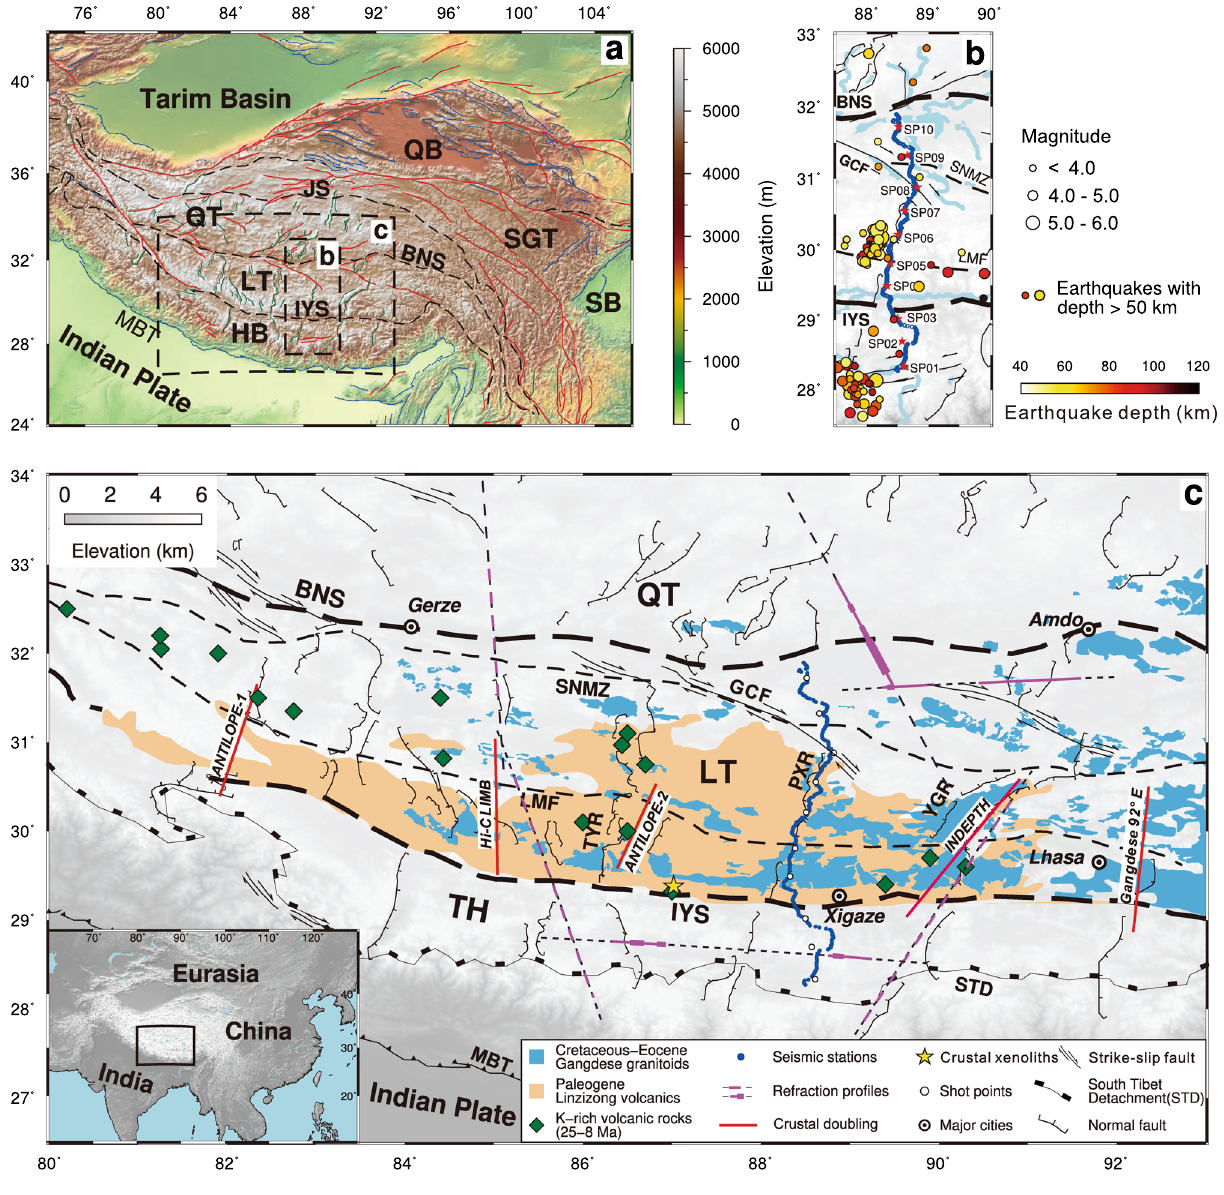
Fig. 1 Topographic map, seismic pro fi le location in Tibet and geologic setting. a Topographic map with major tectonic units and sutures. Black rectangles show locations of maps in b and c . b . Location of seismic refraction/wide-angle re fl ection pro fi le across LT and TH. Blue dots: seismometer locations; red stars: seismic source locations; circles: location and hypocentre depth for all deep (>50 km depth) earthquakes within the map from 1990 to 2017 (ISC, http://www.isc.ac.uk/). c Major geological structures 62,63 and areal coverage of three series of volcanism 48 – 50,64 . Locations of proposed underthrusted Indian Plate from receiver functions ( “ crustal doubling ” ) are marked 12,13,15 – 17 . Earlier seismic refraction/wide-angle re fl ection pro fi les are shown by stippled lines, and thick purple lines indicate ray coverage for Moho re fl ections. Insert shows location of study area. QB Qaidam Basin, SB Sichuan Basin,